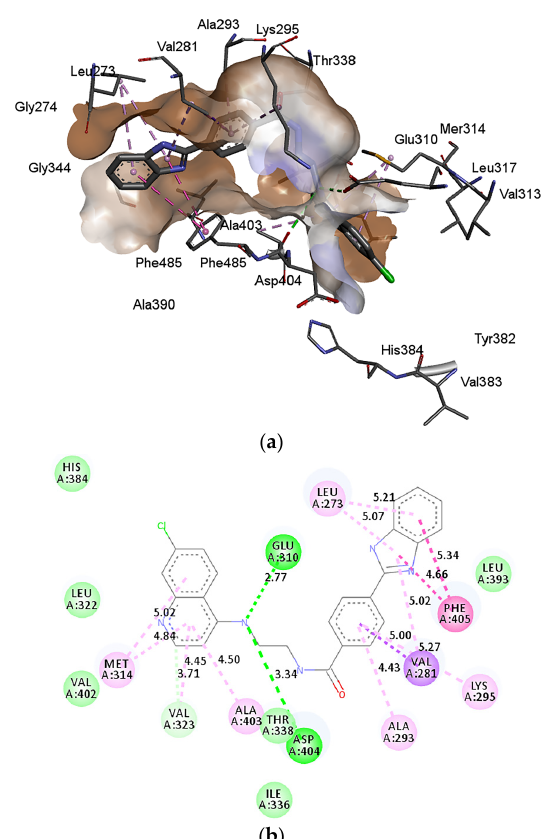
Figure 7. ( a ) Three-dimensional representation of interactions of compound 12d into the biding site of c-Src (represented as hydrophobic surface). Hydrophobicity: dark brown (3.0), dark blue ( − 3.0). ( b ) Two-dimensional representation of interactions of compound 12d with c-Src in binding site (dark green = conventional hydrogen bond; green = van der Waals; light green = carbon hydrogen bond; purple = π - σ interactions; light purple = π - π interactions; pink = π - π T-shaped interactions).